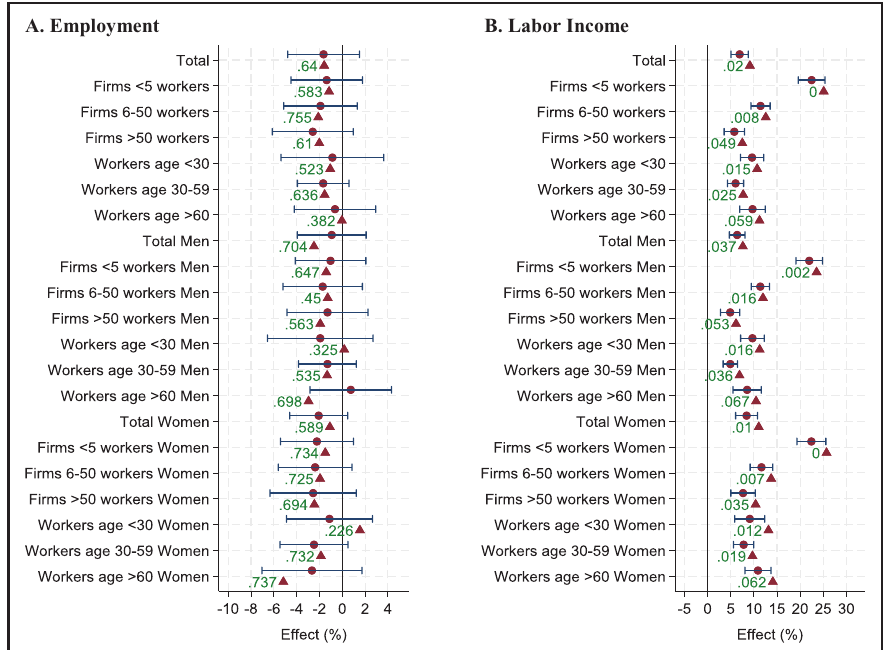
Figure 3 Heterogeneity results,